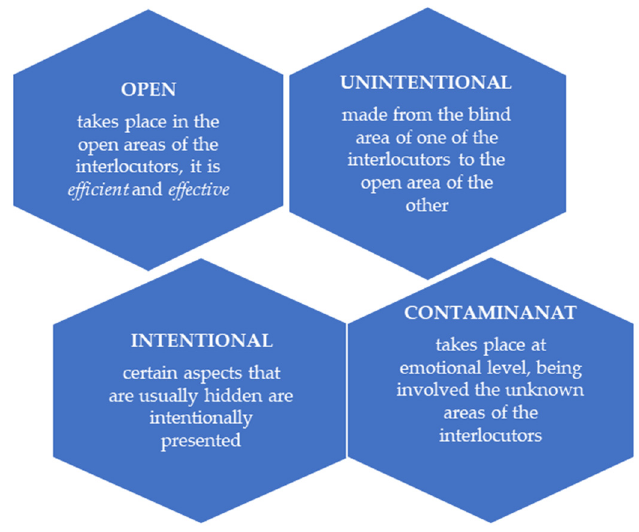
Figure 2. Connection forms.